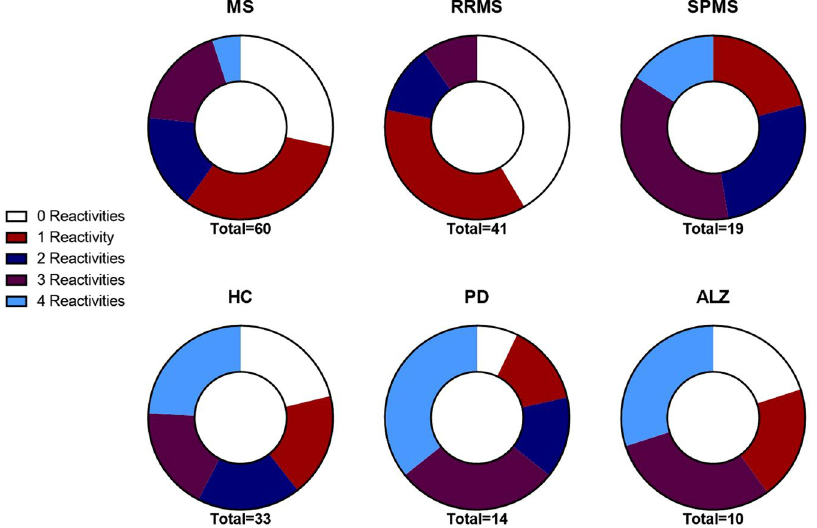
Figure 2. Doughnut charts indicating the proportion of serum samples of total multiple sclerosis (MS), relapse- remitting MS (RRMS), secondary progressive MS (SPMS), healthy controls (HC), Parkinson’s disease (PD) and Alzheimer’s disease (ALZ) patients that were reactive with multiple Hp antigens p54-flagellin, p50, p41 and p29-